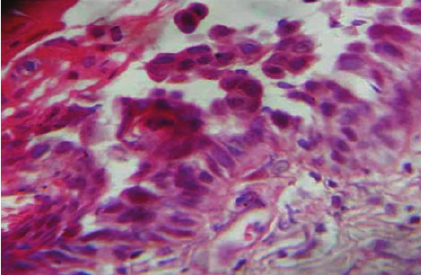
Figure 4: Acantholytic Tzanck cells within the suprabasal split (H&E stain, ×